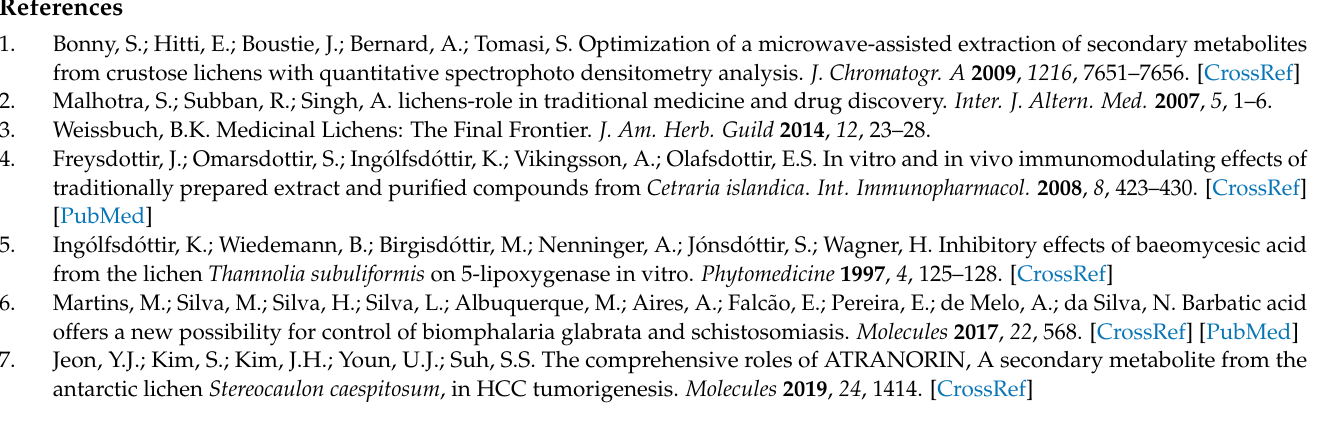
H-NMR spectrum; Figure S2: Atranorin 1 H-NMR spectrum; Figure S3: 1H-NMR (A), HSQC